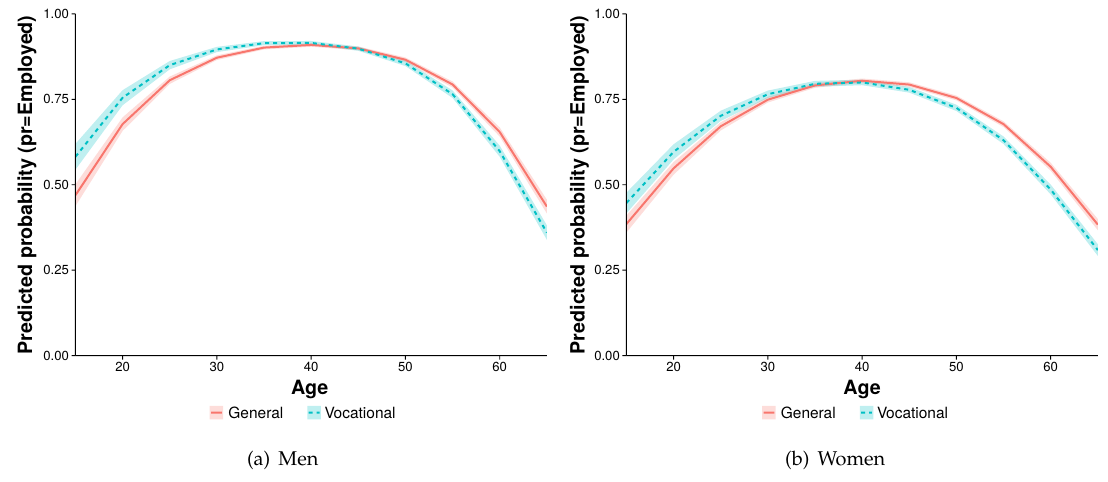
Figure 2: Predicted probabilities of employment by type of education (vocational/general). Note: The estimates of the predicted probabilities are based on model 3 with the full set of predictors. All variables besides the dummy for vocational education are set at their means for this prediction. Age is used in its original form with years of age corresponding to values of the variable. Source: PIAAC 2012, release March 2015, own